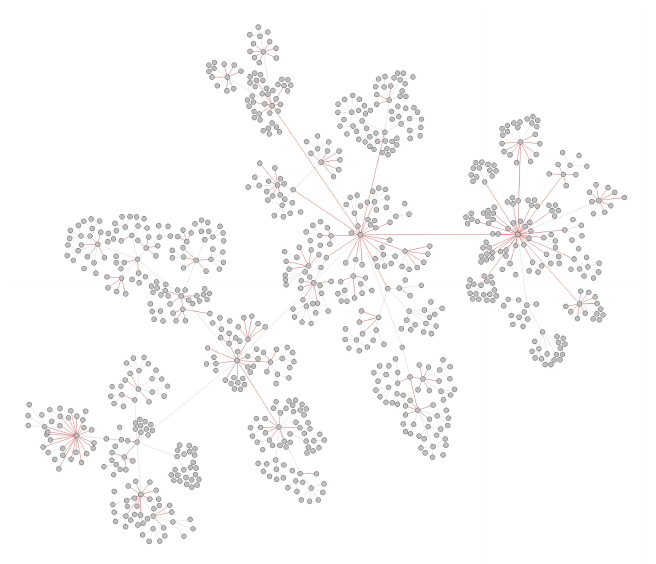
Figure 6. Reconnected network, red edges are abnormal edges with undetected nodes in